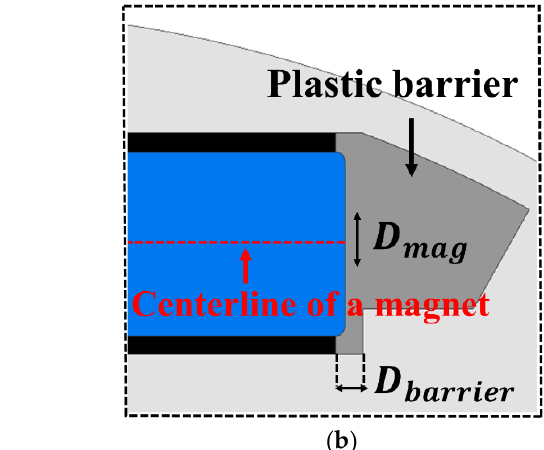
Figure 8. Setting of design variables: ( a ) leakage flux path; ( b ) design variables.